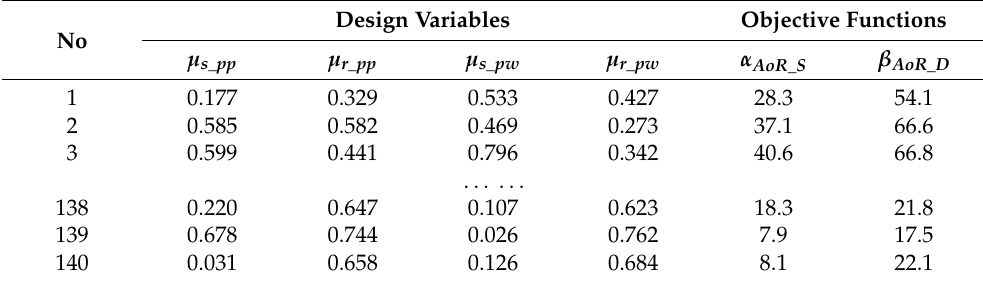
Table 7. Matrix of 140 sample points based on LHS sampling (partial data; full data in Appendix A).